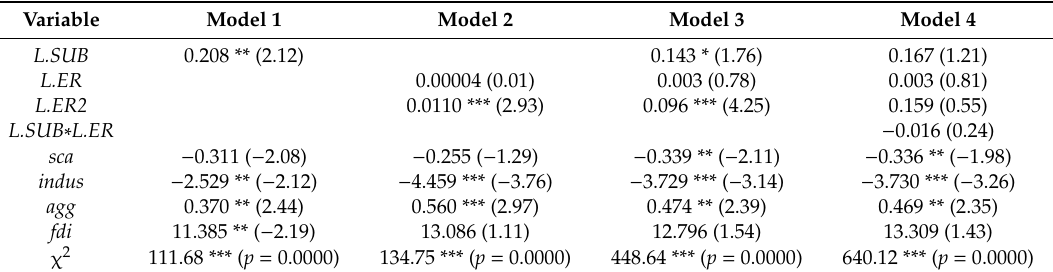
Table 6. Estimation results of the e ff ects of government R&D subsidies and environmental regulations on MGIE (from a time